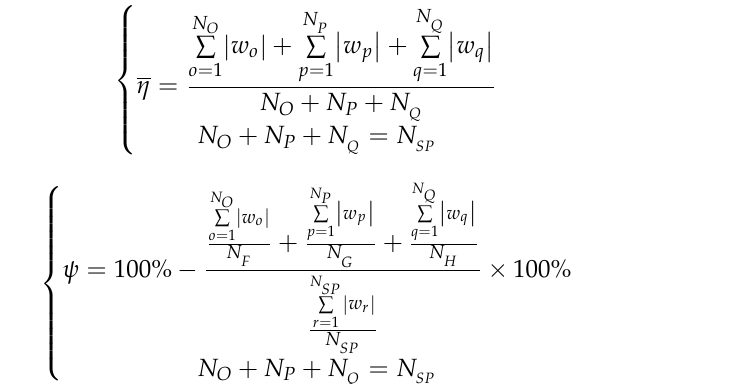
(Figure 12). The calculation results of each curve are shown in Figure 13, and the walking- assistance efficiencies were 5.41%, 9.02%, 16.88%, 18.51%, and 16.72%, respectively, in which the KESM with the optimal parameter combinations exhibited the highest walking- assistance efficiency [3,25]. The walking-assistance efficiencies of simulation are generally higher than the previous lower-limb-assistant exoskeleton [3,4,23,24,30,31] but far less than the theoretical limit of walking-assistance, which is